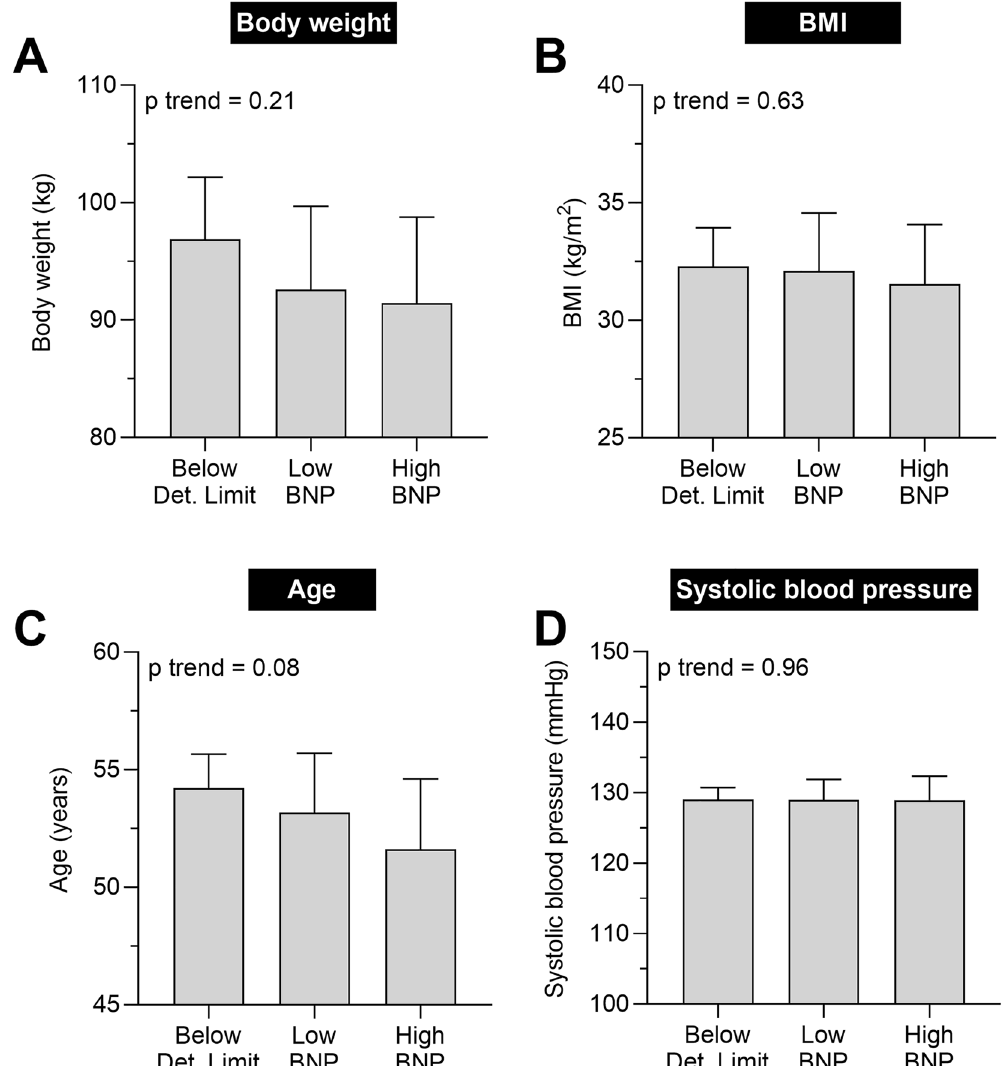
Figure 3. Associations between NT-proBNP concentration and ( A ) body weight, ( B ) BMI, ( C ) age, and ( D ) systolic blood pressure. Bars denote mean and error bars denote 95% CI of the mean. P trend analyses were performed using a linear regression model with NT-proBNP group as ordinal covariate and the variable of interest as dependent variable. Definition of NT-proBNP groups is shown in Fig. 2. BMI, body mass index; CI; confidence interval; NT-proBNP, N-terminal pro brain natriuretic